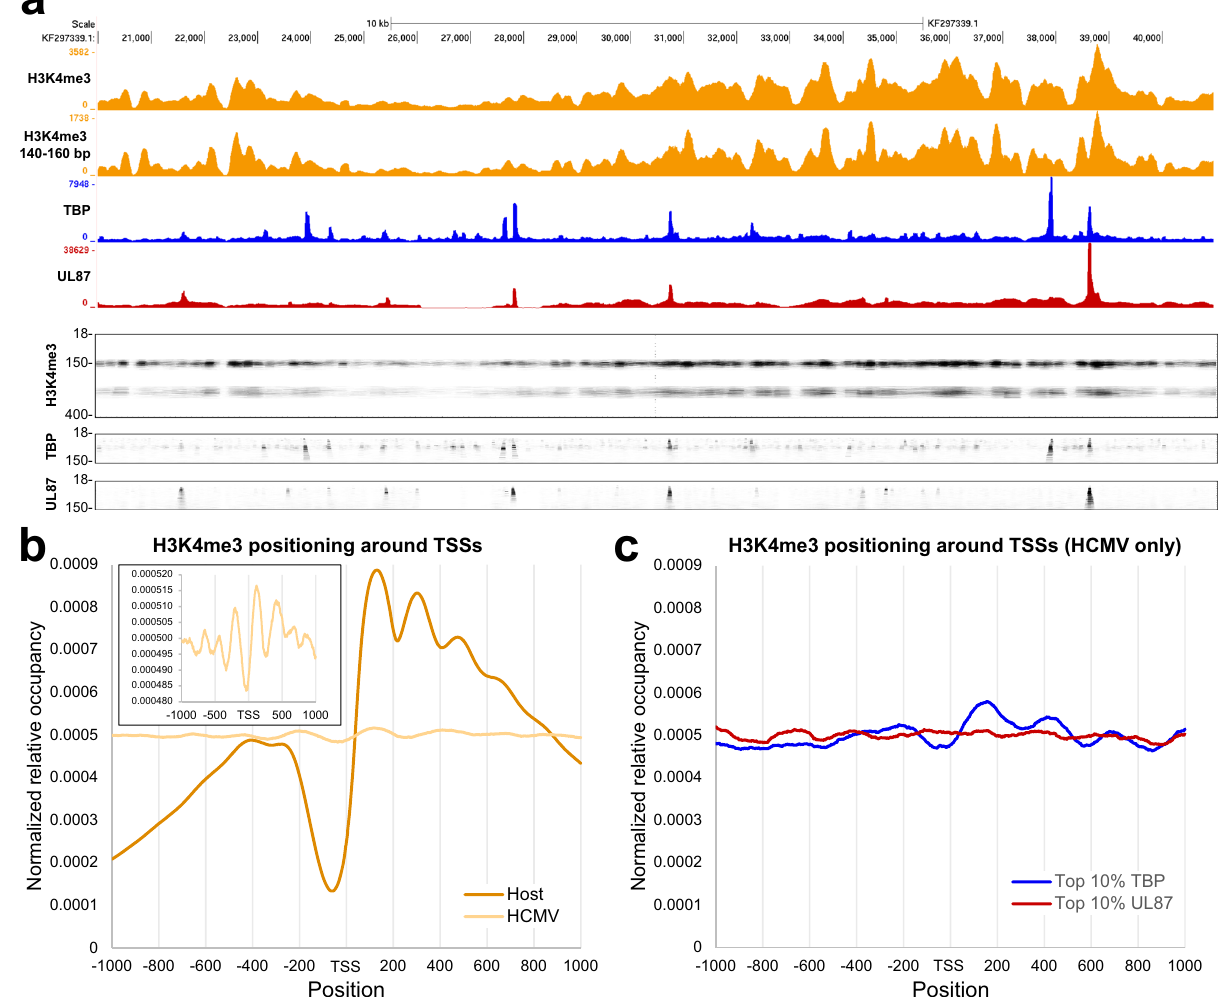
Fig. 6 Analysis of TBP and UL87 PICs on the HCMV genome. a Genome browser tracks from all fragment sizes for H3K4me3, TBP, and UL87 datasets and for the 140 – 160 bp fragments from H3K4me3 (all Exp4) compared directly to fragMaps of the same region of the HCMV genome. The H3K4me3 fragMap depict fragments between 18 – 400 bp whereas TBP and UL87 fragMaps depict fragments between 18 – 150 bp. b Normalized metaplot of H3K4me3 signal around the MaxTSS of 12,229 HFF truQuant promoters and 1461 TB40/E TSRs. The inner graph shows the HCMV metaplot with a different Y-axis (Exp4). c Normalized metaplot of H3K4me3 signal around the top 10% of HCMV TSRs determined by amount of TBP PIC feature or UL87 PIC feature